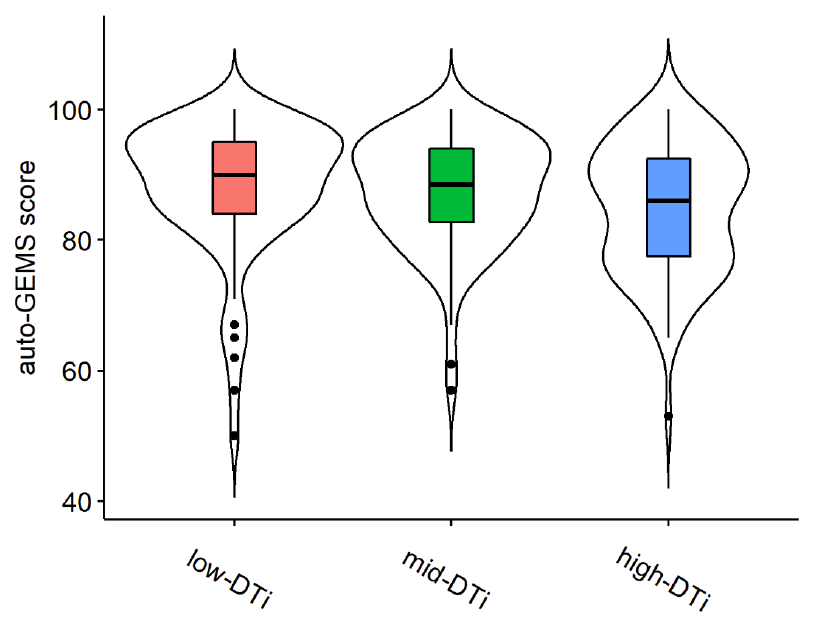
Figure 8. Distribution of participants’ auto-GEMS scores in the three clusters: low-DTi, mid-DTi, and high-DTi. For the Education score, the high-DTi subgroup had significantly lower scores than the low-DTi subgroup (mean.rank.diff = 27.831, W= 4064.5, p = 0.028). There was no dif- ference between the high-DTi and mid-DTi subgroups (mean.rank.diff = 10.439, W = 4170, p = 0.153), and there was no difference between the mid-DTi and low-DTi subgroups (mean.rank.diff = 17.392, W = 3880.5, p = 0.081). 5. Discussion In this study, we investigated how Dual-Task interference DTi in a cognitive–cogni- tive dual-task paradigm impacts performance at different ages. A cohort of healthy mid- dle-aged and elderly participants (50–89 years) was tested with a set of online tasks. A sustained auditory attention task was performed during image memorization to study its impact on subsequent image recognition. We expected DTi to increase with increasing task demands and with the age of the participant. Surprisingly, we found that, despite a general age-related decline in mnestic and attentional performance, DTi was stable across age in both memory and sustained attention tests. Notably, the absence of the expected age-dependent increment in DTi could not be attributed to the participants’ incorrect ex- ecution of the sustained attention task. In fact, we included in the analysis only partici- pants with performance that ensured ACPT execution in accordance with the instructions. Although no time pressure was applied to the task, we also analyzed reaction times. The reaction time results (reported in Appendix A) mirror the findings for accuracy, as they increase with cognitive load and age, but show no substantial aging–related cost increase. Therefore, the present findings are remarkably robust, as the stability of DTi across age is confirmed for both accuracy and reaction time. Based on the evidence in this study, we can therefore argue that: (1) There is a clear linear decline in performance in both the memory task and the sus- tained attention task with increasing age;